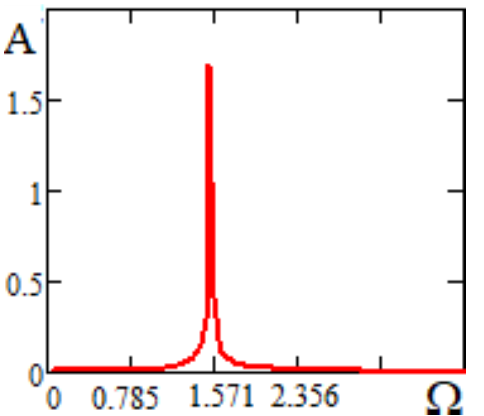
Figure 19. Amplitude response of oscillations at K 3 = 0 . 075, µ 1 = 0 . 09, µ 3 = 0 , 18.